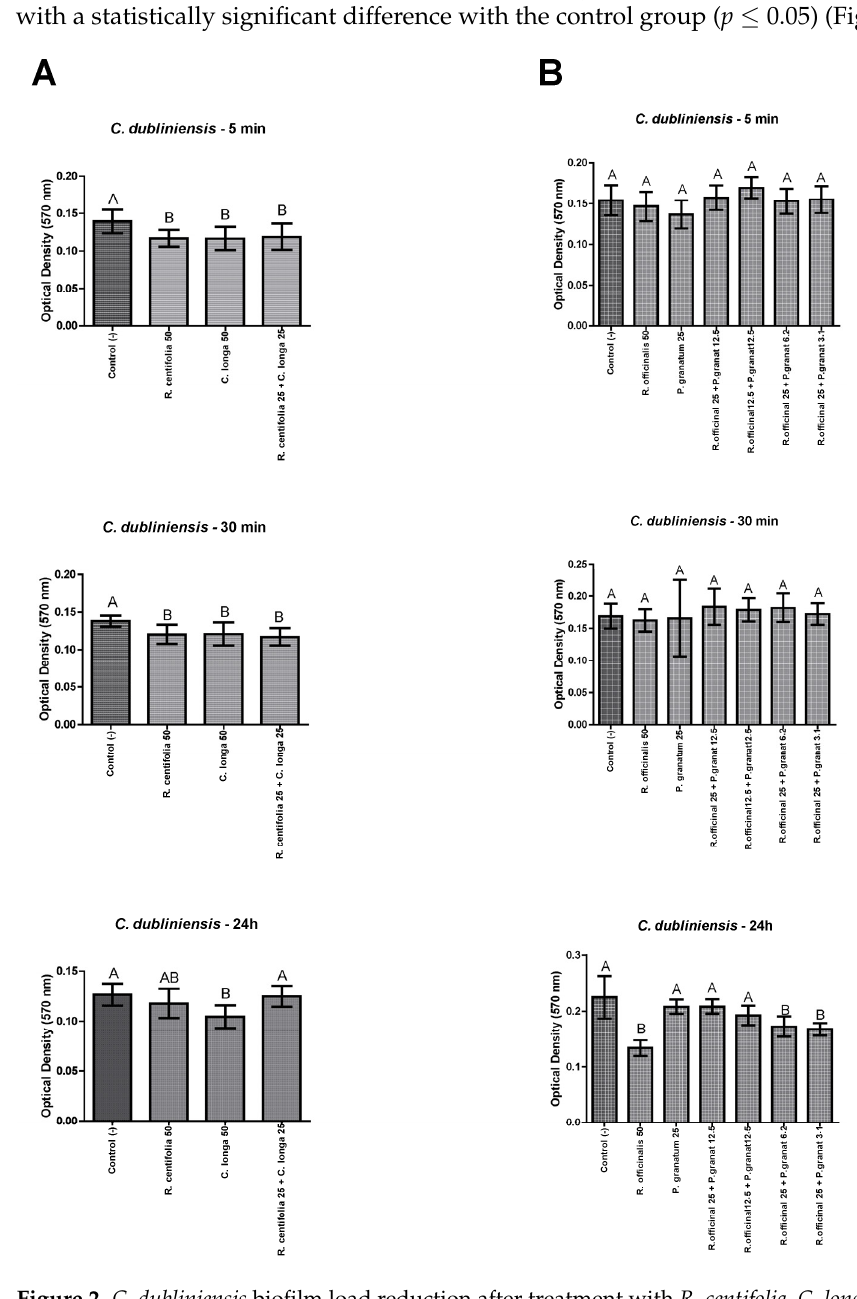
Figure 2. C. dubliniensis biofilm load reduction after treatment with R. centifolia , C. longa , R. officinalis , and P. granatum glycolic extracts, and their combinations, for 5 min, 30 min, and 24 h. Legend: Different upper ‐ case letters indicate a statistically significant difference.